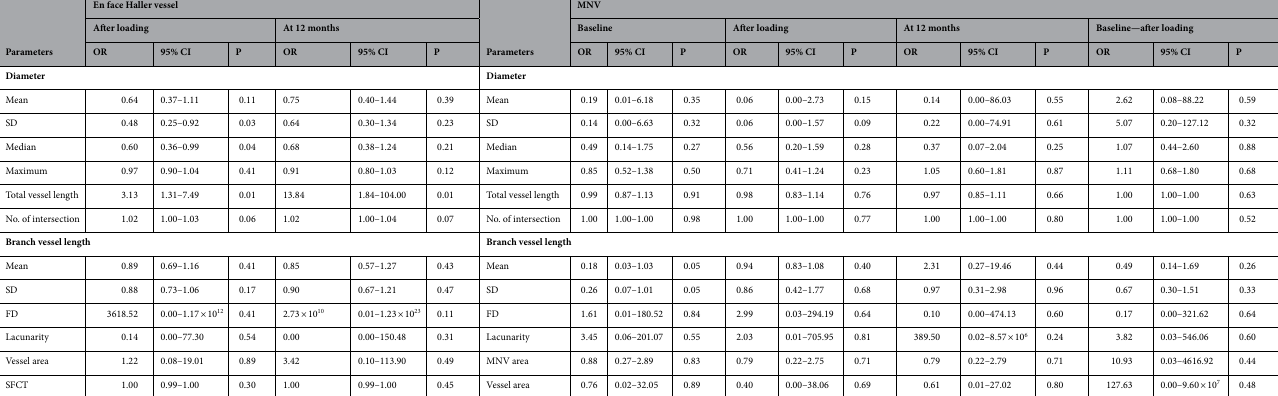
Table 1. Univariate logistic regression analysis of the infrequent injection group based on en face Haller vessel and MNV parameters. Age and sex were adjusted. Unit of vessel area, mm 2 ; unit of total vessel length, mm; unit of diameter and branch vessel length, 10 μm. MNV, macular neovascularization; Baseline—after loading, baseline value of parameter subtracted by the value after loading doses; No., number; SD, standard deviation; FD, fractal dimension, SFCT, subfoveal choroidal thickness; OR, odds ratio; CI, confidence